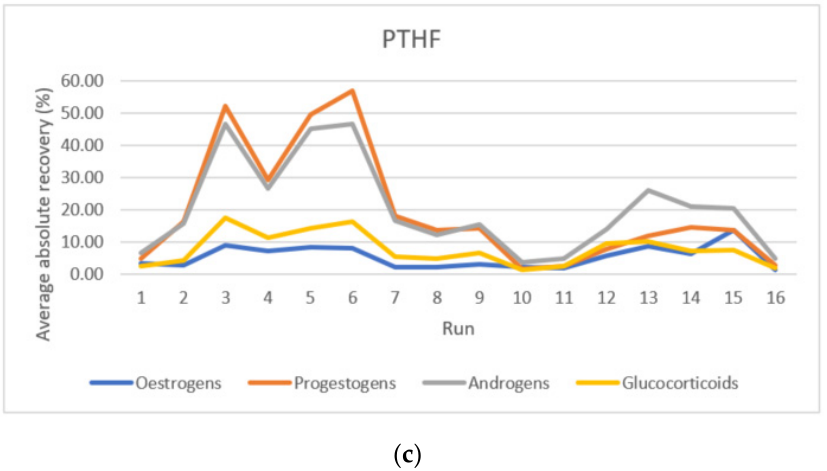
Figure 1. Average absolute recoveries for analytes of the different steroid hormone families under study for the different runs of the factorial experimental design. ( a ) Carbowax ® 20M, ( b ) PEG 300, and ( c ) PTHF.